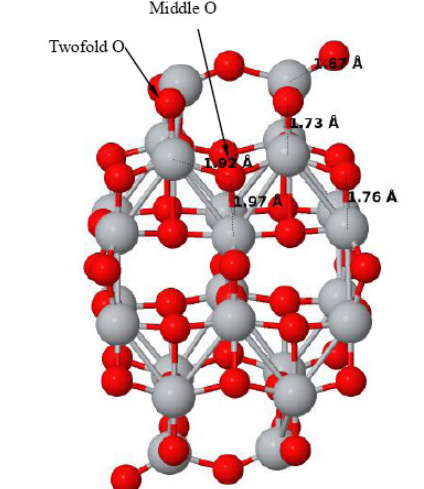
resultsFig. 1. A 3×2×1 supercell of TiO atoms accordingly: Ti in gray and O in